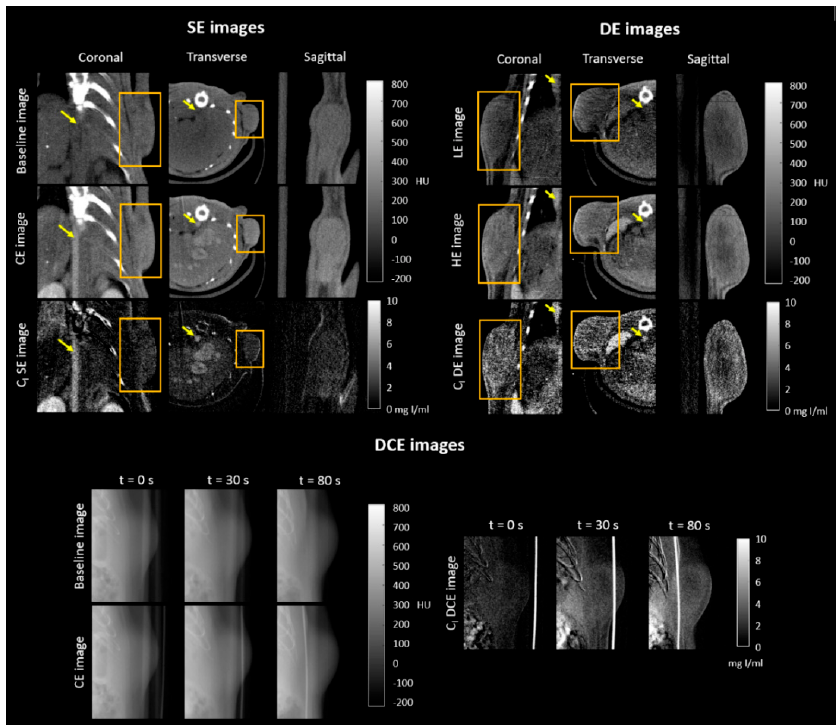
Figure 1. Qualitative evaluation of single-energy (SE) and dual-energy (DE) micro-computed tomography (micro-CT) images and dynamic contrast-enhanced (DCE) planar images of the subcutaneous C6 glioma model. Left upper panel: coronal, transverse, and sagittal views are shown for a baseline image, a contrast-enhanced (CE) image, and the iodine concentration (C I ) SE subtracted image. Right upper panel: coronal, transverse, and sagittal views are shown for a low-energy (LE) image, a high-energy (HE) image, and the C I DE subtracted image. Abdominal aorta and tumor are indicated by an arrow and square, respectively, in the coronal and transverse views. Only the tumors were depicted in the sagittal views. Bottom panel: Three acquisition times are shown for a baseline planar image, a CE planar image, and the C I DCE subtracted image. The presence of the catheter used for the administration of the contrast agent was observed in the images.